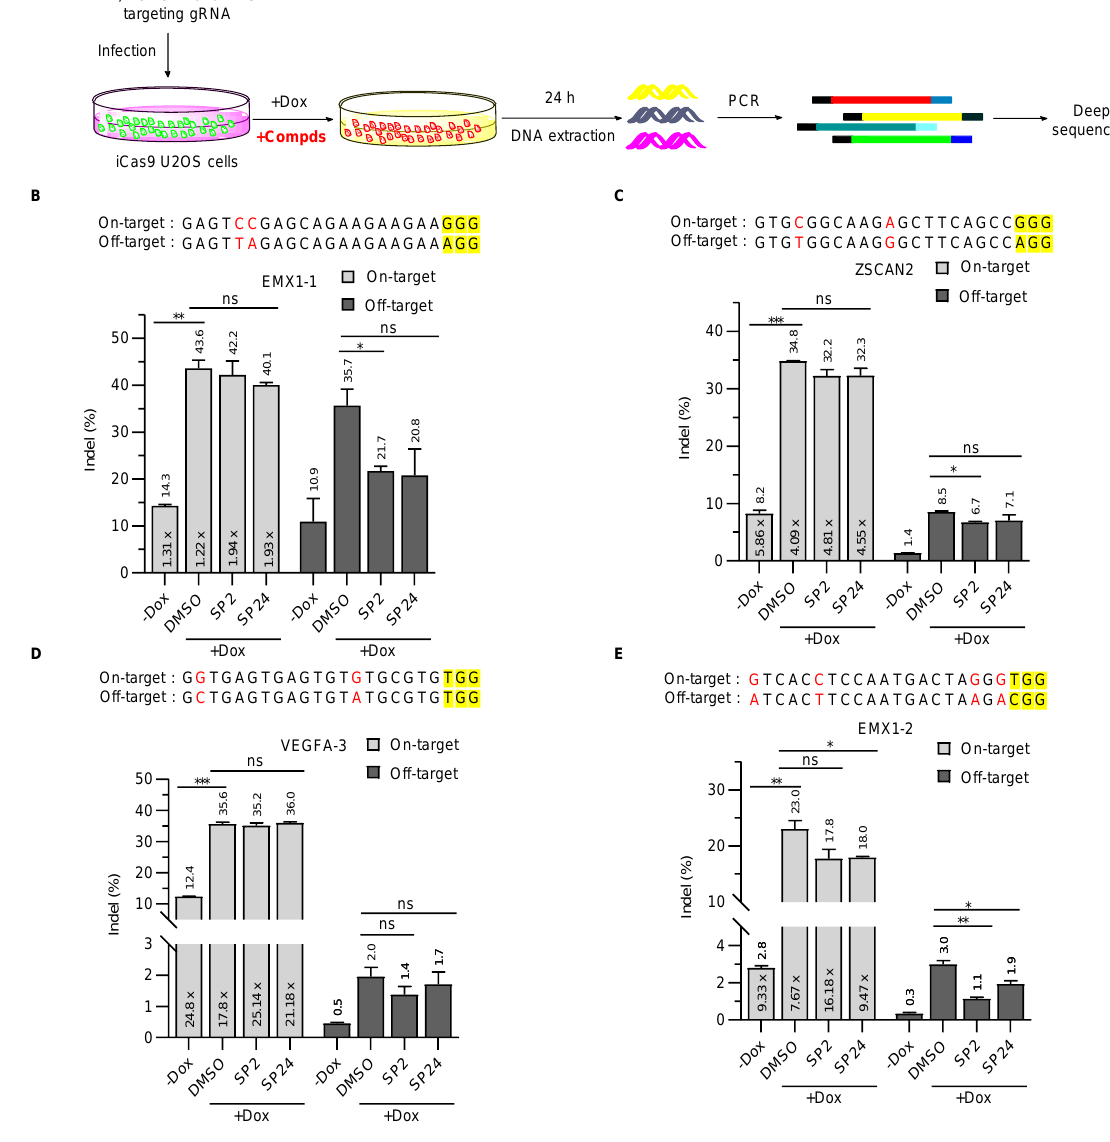
Figure 4. SP2 and SP24 can improve the specificity of SpCas9 in cells. ( A ) To investigate the ability of SP2 and SP24 to inhibit SpCas9 in cells, we established iCas9-expressing U2OS cell lines that also stably expressed gRNAs targeting different endogenous sites. The cells were then cultured with or without Dox and SP2 (2.5 µ M)/SP24 (1 µ M for VEGFA-3 locus, and 0.5 µ M for others) for 24 h before genomic DNA extraction and deep sequencing of on- and off-target sites. ( B , E ) The percentage of indels at on- and off-target sites for gRNAs targeting EMX1-1 ( B ), ZSCAN2 ( C ), VEGFA ( D ), and EMX1-2 ( E ) were calculated and plotted as shown. On-target and off-target sites editing efficiency of SpCas9 with SP2 and SP24 treatment at EMX1-1 ( B ), ZSCAN2 ( C ), VEGFA ( D ), EMX1-2 ( E ) locus. Data are from two independent biological replicates. The multiple value in the panel columns was the ratio of on-target vs. off-target indels that were calculated for each condition and target site. PAM sequences are highlighted in yellow. Mismatched bases in on- and off-target sites are marked in red. Error bars indicate mean ± SD. The p values were determined by two-tailed unpaired t -test, ns means no significance, (*) p < 0.05, (**) p < 0.01, and (***) p < 0.001.